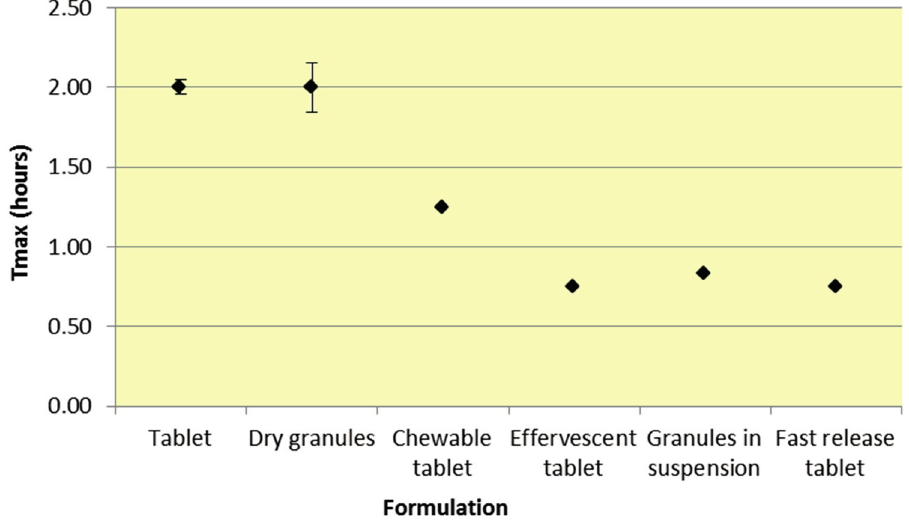
Figure 6. Summary SA T max for various 500 mg formulations (Median ±